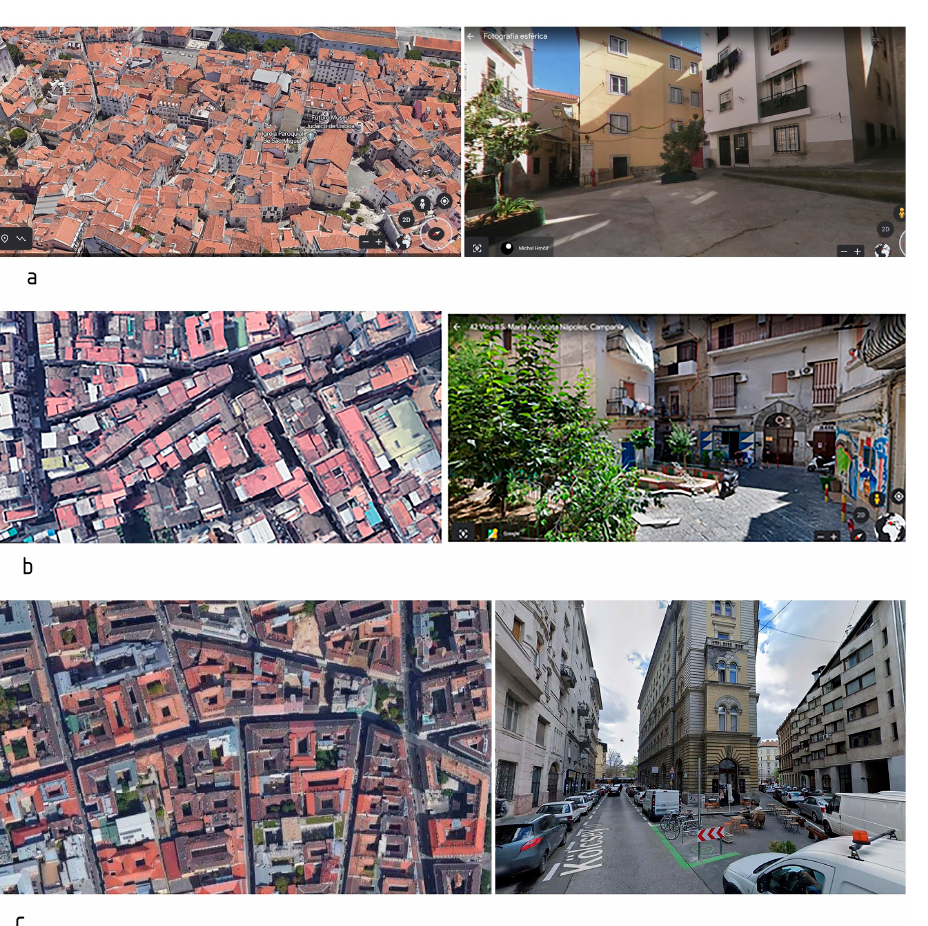
Figure 21. Residual spaces inserted in the urban fabrics of the European cities of ( a ) Lisbon (Alfama district), ( b )Naples (Pendino district) and ( c ) Bucharest (District VIII).